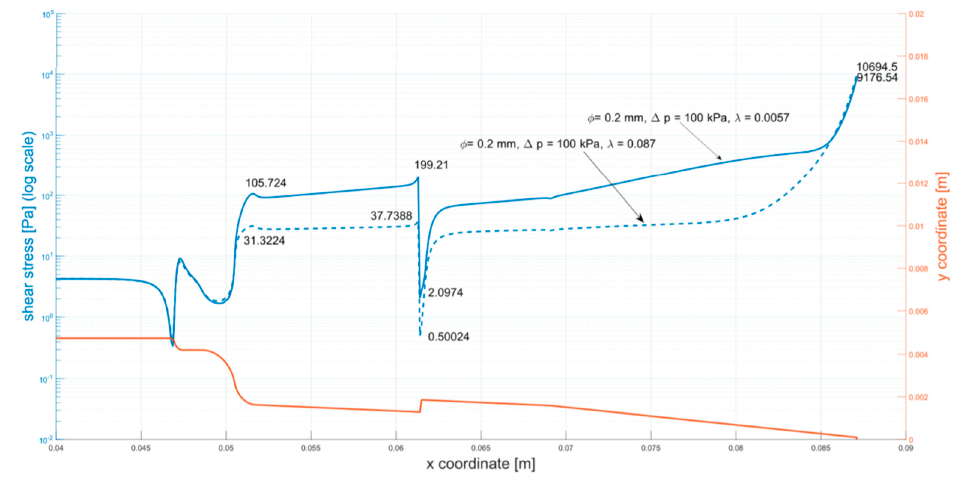
Figure A3. Shear stress at the walls of the cartridge ( φ = 0.2 mm, ∆ p = 100 kPa).